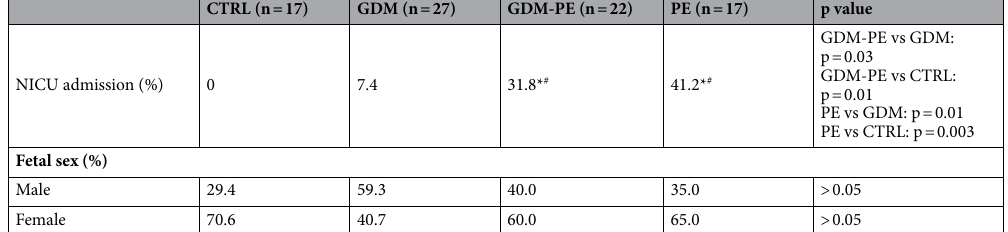
Table 1. Clinical features of the study population. Comparisons of CTRL, GDM, GDM-PE and PE and PE pregnancies clinical features. Values are expressed as mean ± Standard Error (SE) and percentag e . Comparisons among groups were done by ANOVA, which, if significant, was followed by pairwise analysis using the Bonferroni method. Categorical variables are presented as frequencies (percentages) and the comparison between different groups was done with Chi-Square Test. Significant differences (p ≤ 0.05): # differences indicating a significant effect compared with CTRL; *differences indicating a significant effect compared with GDM; § differences indicating a significant effect compared with PE and ^ differences indicating a significant effect compared with GDM-PE. BMI body mass index, A/REDF absent/reverse end diastolic flow, AST aspartate aminotransferase, ALT alanine aminotransferase, NICU Neonatal Intensive Care Uni.